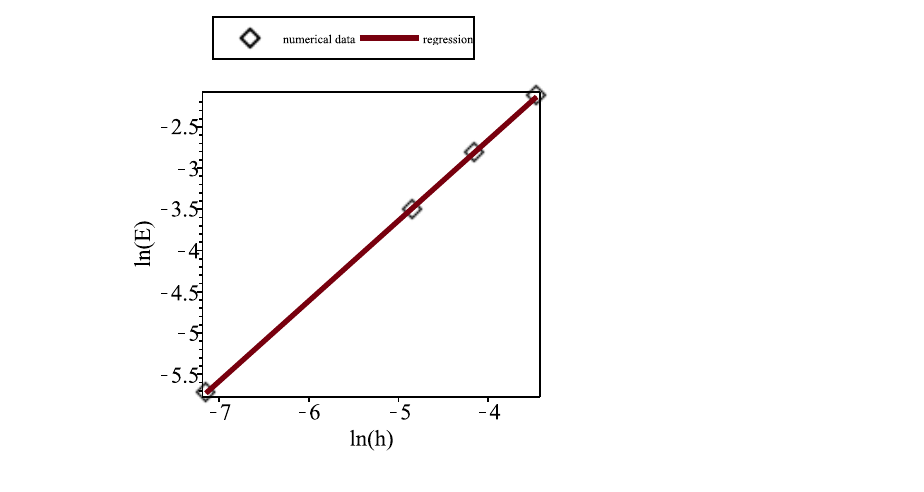
Figure 2. Steady-state problem: Regression line is ln ( E ) = 1.236743707 + 0.9745811176ln ( h ) with h = c − a N